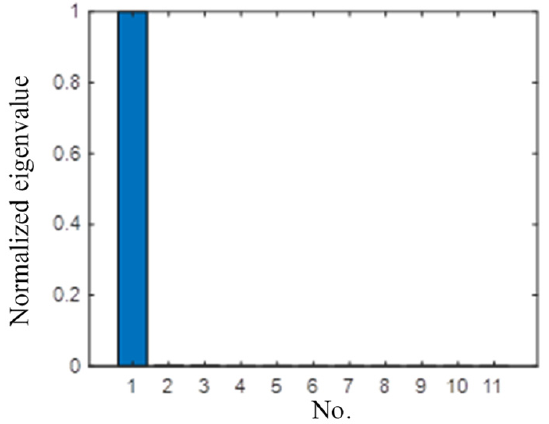
Figure 19. Scattered signal of single ‐ damage case.